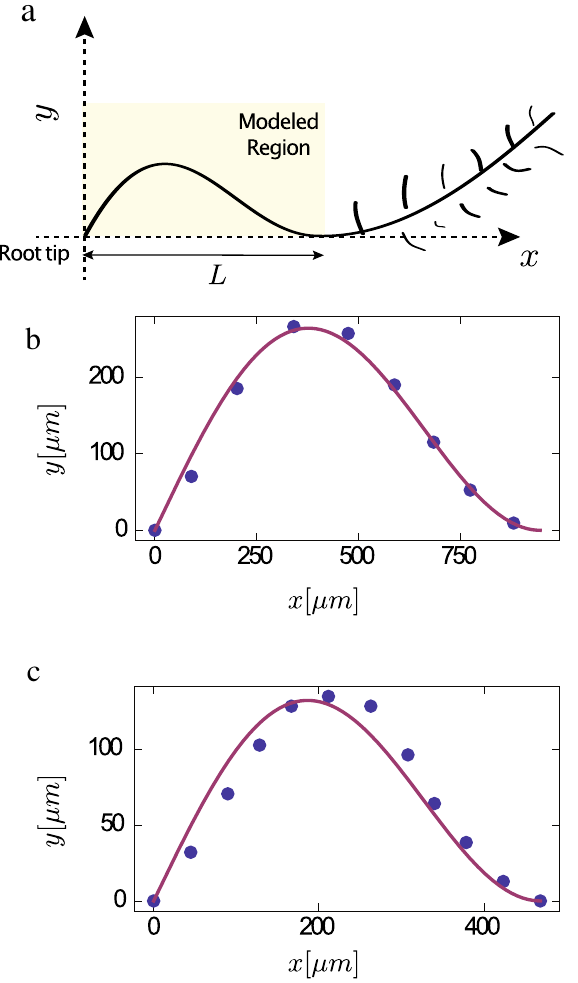
Figure 5. Comparing experiments to theory: ( a ) An illustration of the region of the root in the experiments of Thompson and Holbrook 18 that is compared to the elastic solution for pinned-clamped boundary conditions (Eq. (9)). ( b ) Fit of Eq. (9) to points taken from the Supplementary Movie of Ref. 18 at t = 10.45 h. The fitting 2 = 0.98 parameter obtained was A = 193.9 µ m with R . ( c ) Fit of the same equation to points taken from the Supplementary Movie of Ref. 18 at t = 13.95 h. The fitting parameter obtained was A = 96.71 µ m with R 2 = 0.938